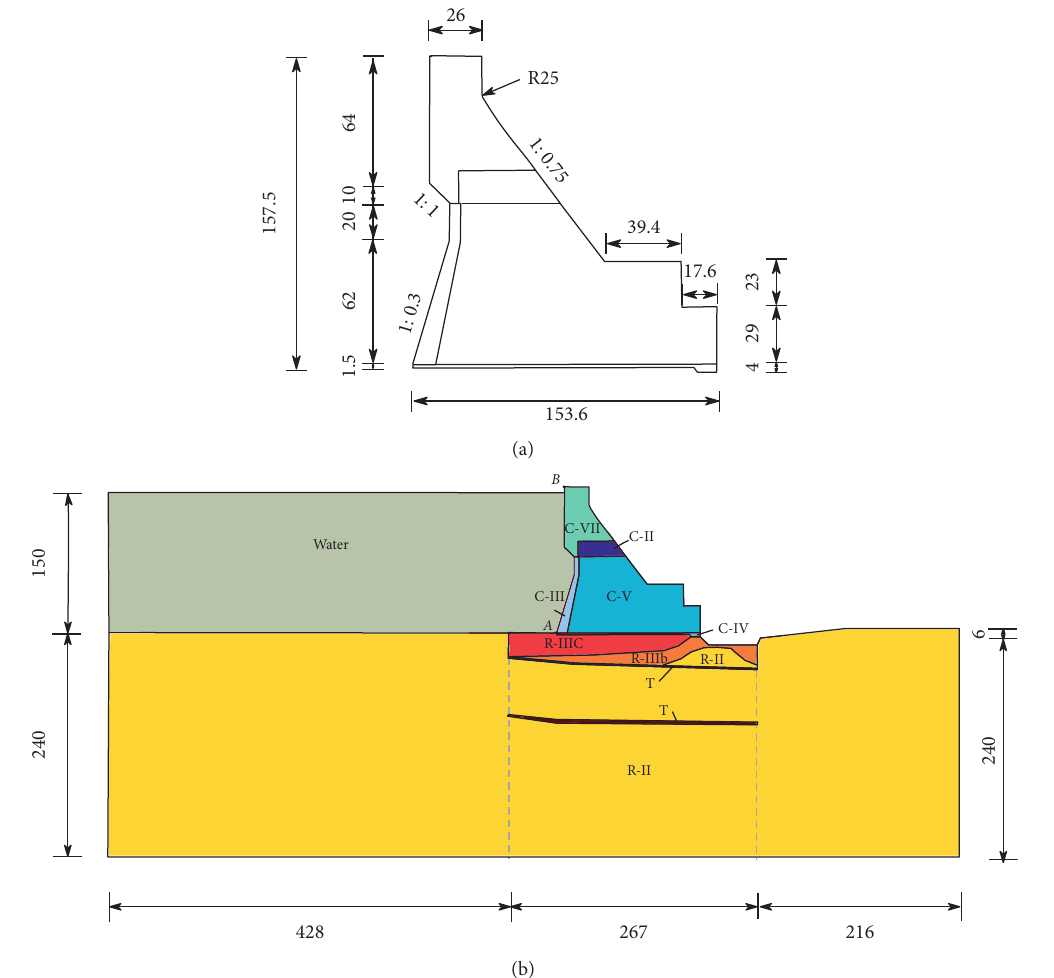
Figure 13: Cross section of the powerhouse monolith of the Jin’anqiao dam (Unit: m). (a) Geometry of the dam. (b) Material distribution and model for the